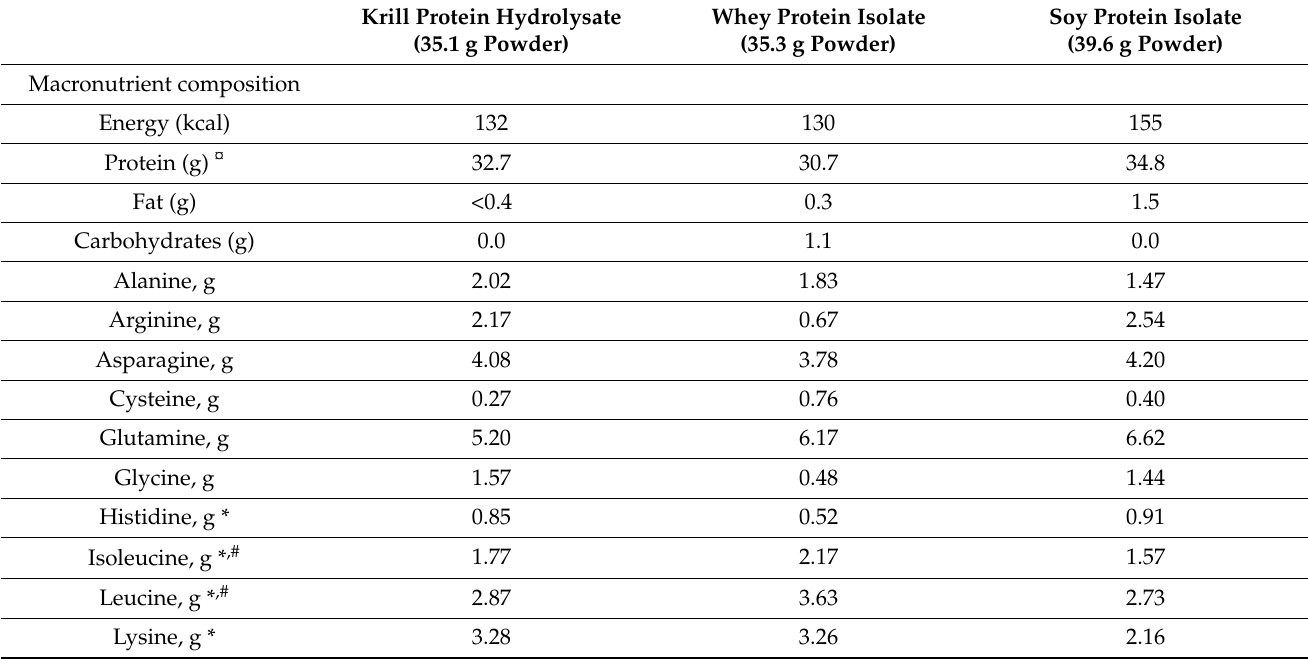
Table 2. Amino acid content in test